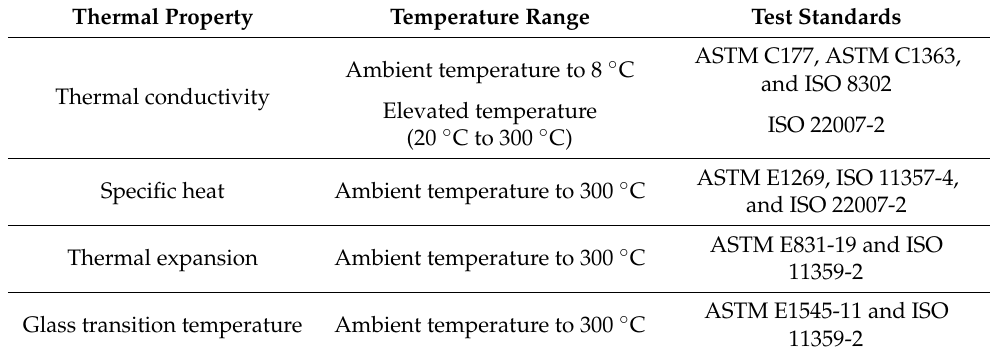
Table 2. Test standards and temperature range for the evaluation of thermal properties of